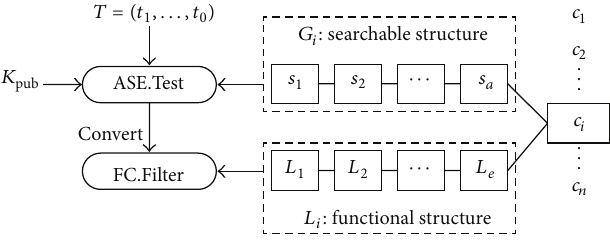
Figure 3: Data structure and search process for asymmetric setting.